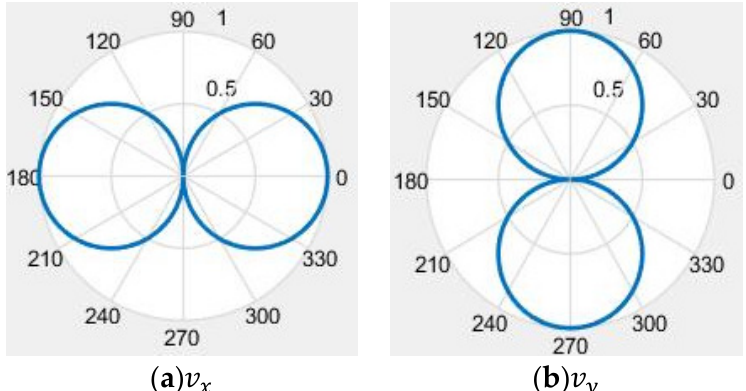
Figure 1. Directivity of cilium MEMS vector hydrophone. ( a ) The directivity in x direction; ( b ) the directivity in y direction.